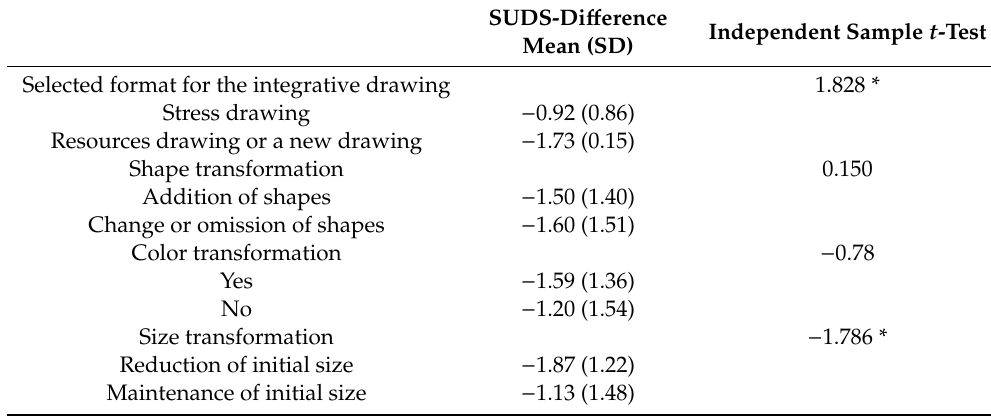
Table 4. SUDS-di ff erence scores by the selected format of the integrated drawing and compositional transformations: stress-drawing versus integrated drawing ( N =